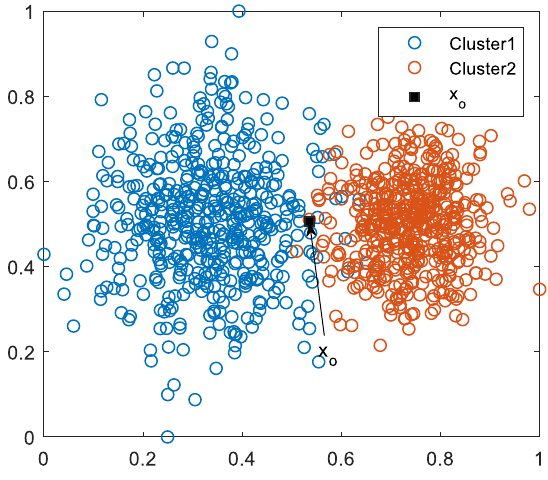
Figure 5. Synthetic two-dimensional data.